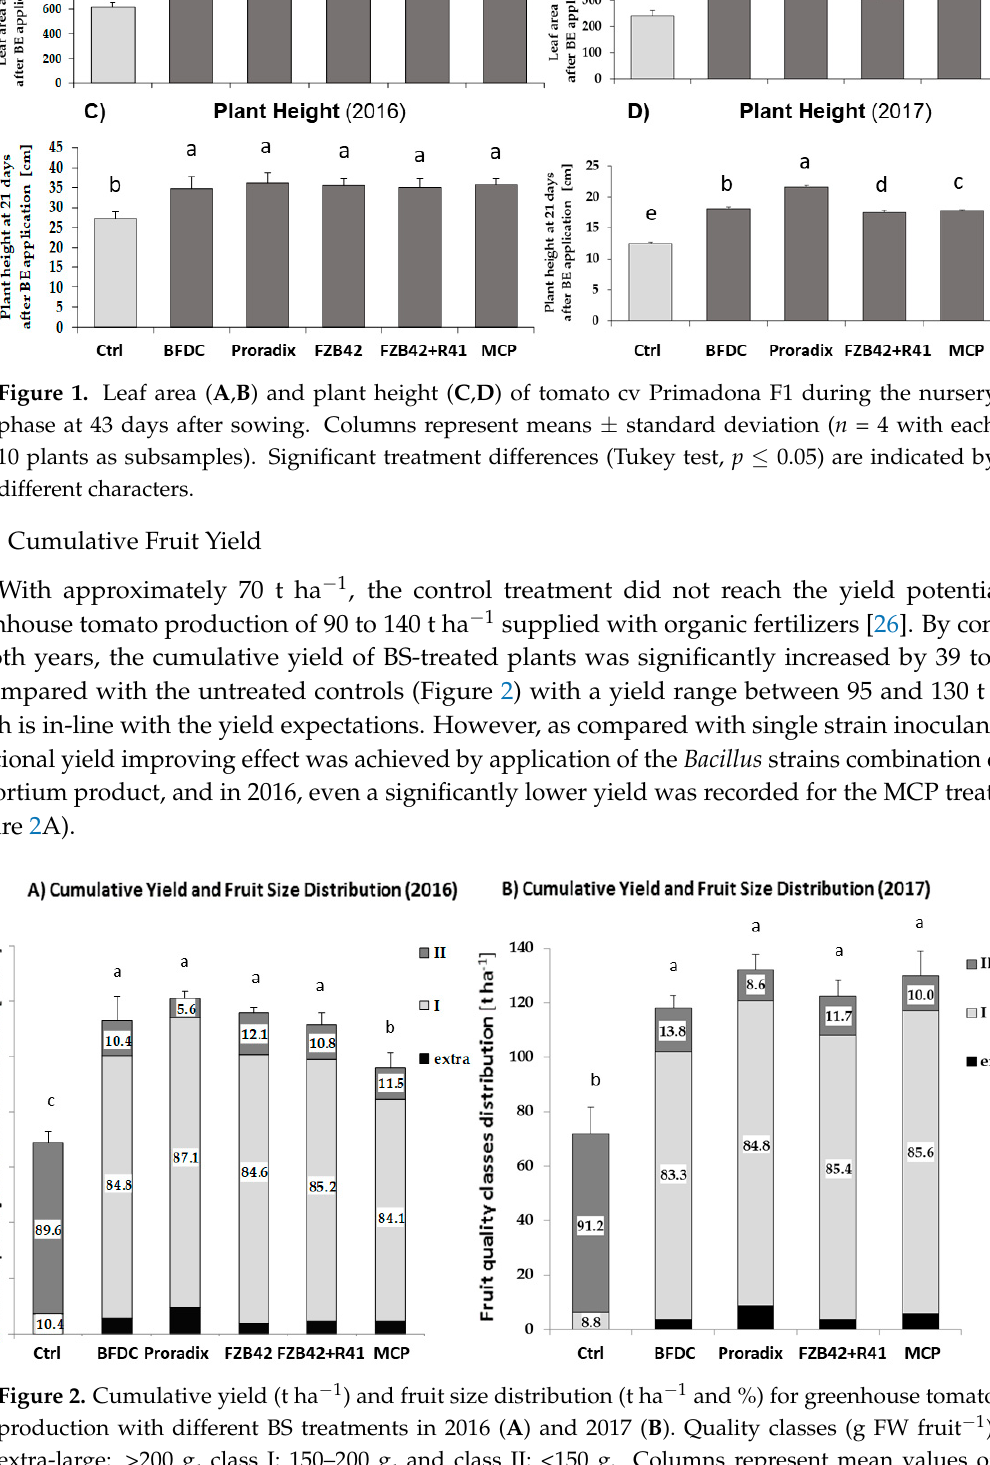
Figure 3. Seasonal yield share of tomato production over the whole harvesting period (June, July, and August) for different BS applications in Romania 2016 (A) and 2017 (B) (fruit yield in t ha − 1 ).